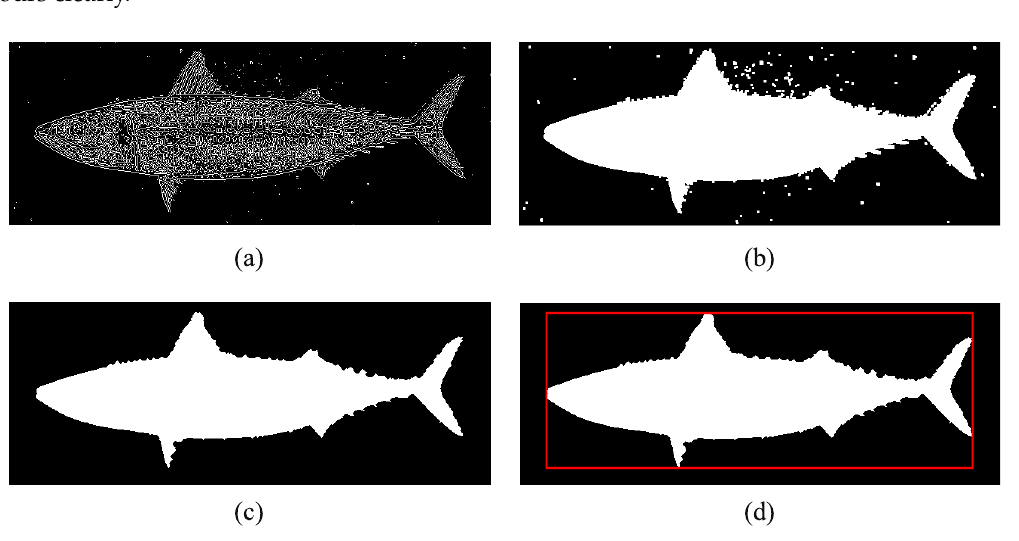
Figure 5. Segmentation and estimation of fish location. ( a ) Edge detection; ( b ) dilation; ( c ) erosion; ( d ) location of fish represented by red